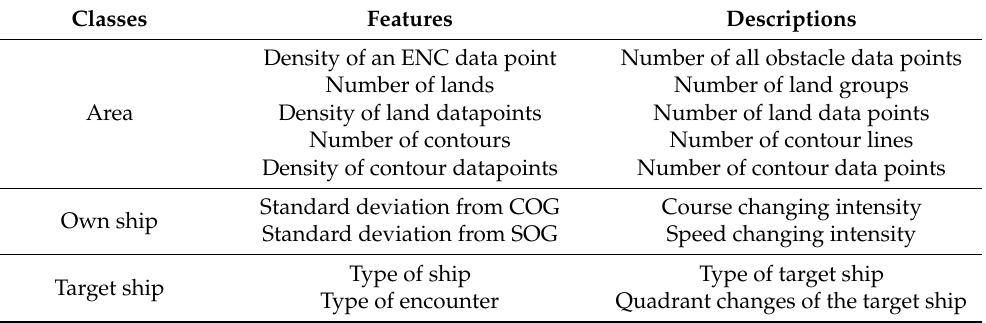
Table 4. Extracted features.